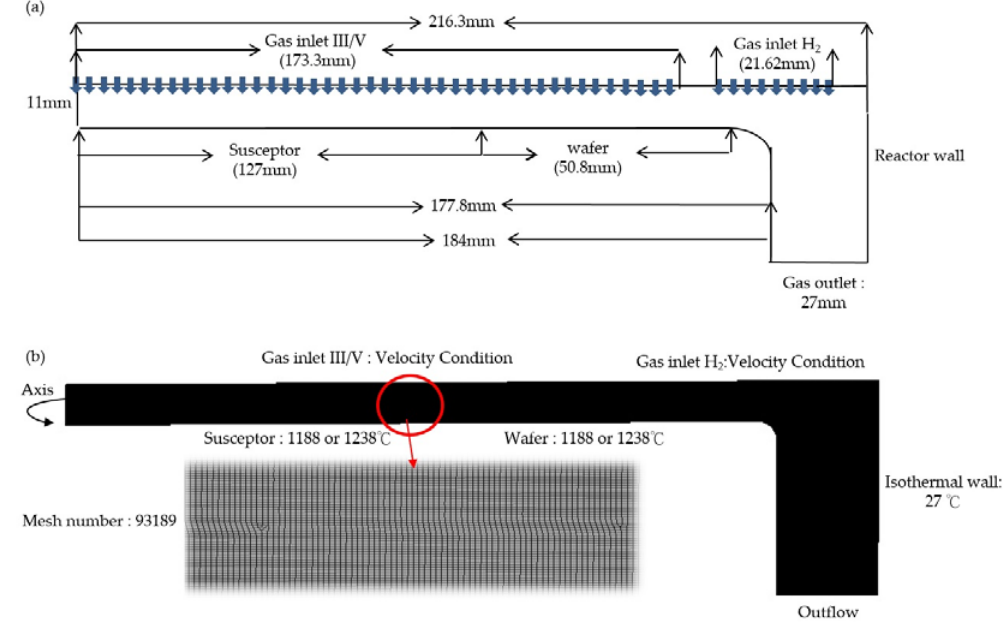
Figure 2. Schematic of ( a ) Aixtron Crius I MOCVD reactor and ( b ) its mesh.